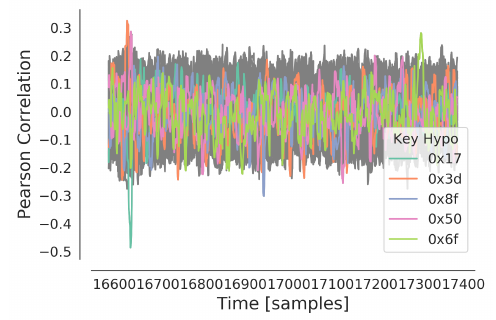
Figure 36: Pearson Correlation coefficients in Step 4 with traces 114-370 (byte 0).